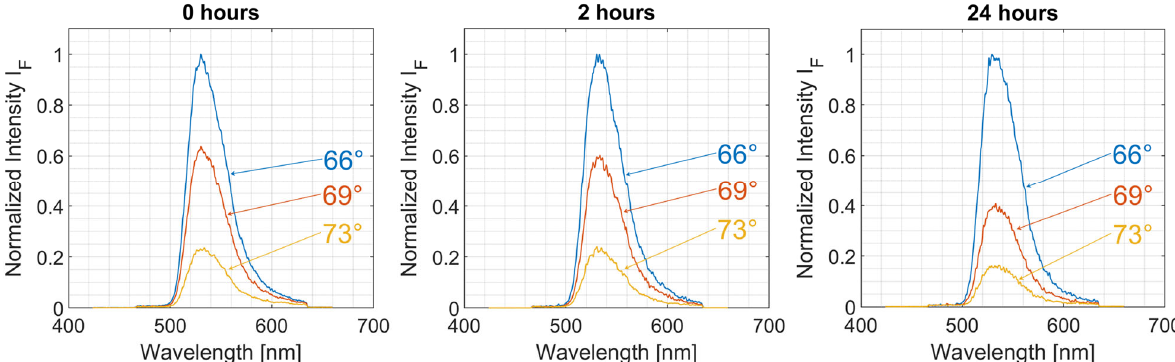
Figure 1. Fluorescence spectra of CHO ‐ pAcGFP1 ‐ Mem cells at varying TIR angles after 0 h, 2 h, and 24 h incubation with doxorubicin (2 μ M) in culture medium. Subcultures with 56–64 cell splittings. 24 h incubation with doxorubicin (2 µ M) in culture medium. Subcultures with 56–64 cell